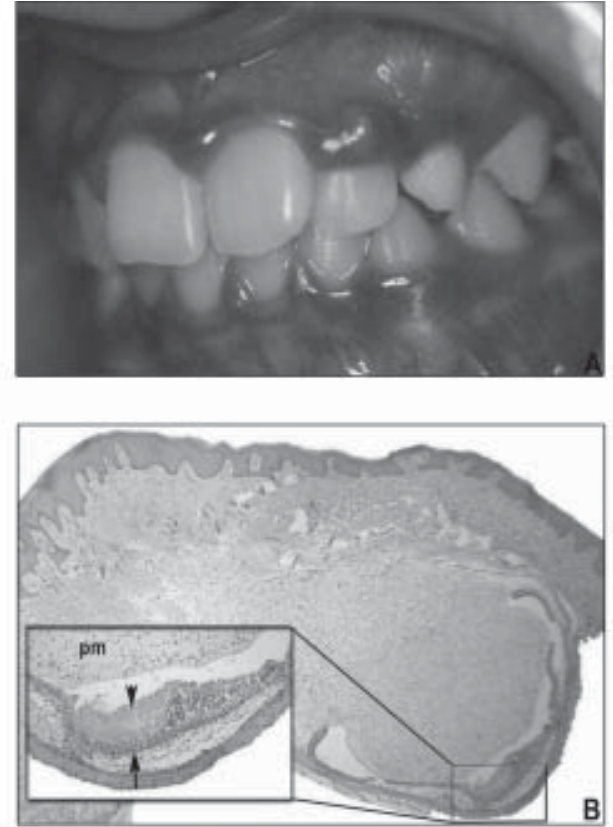
Fig.1. Clinical and histopathological features of the gingival peripheral odontoma. A: Clinical aspect of the lesion. B: Mucosal fragment showing the lesion beneath the surface epithelium. H&E. (original magnification ×100). Rudimentary tooth containing ameloblasts (arrow), enamel matrix (arrowhead) and primitive mesenchymal tissue (pm). H&E. (original magnification